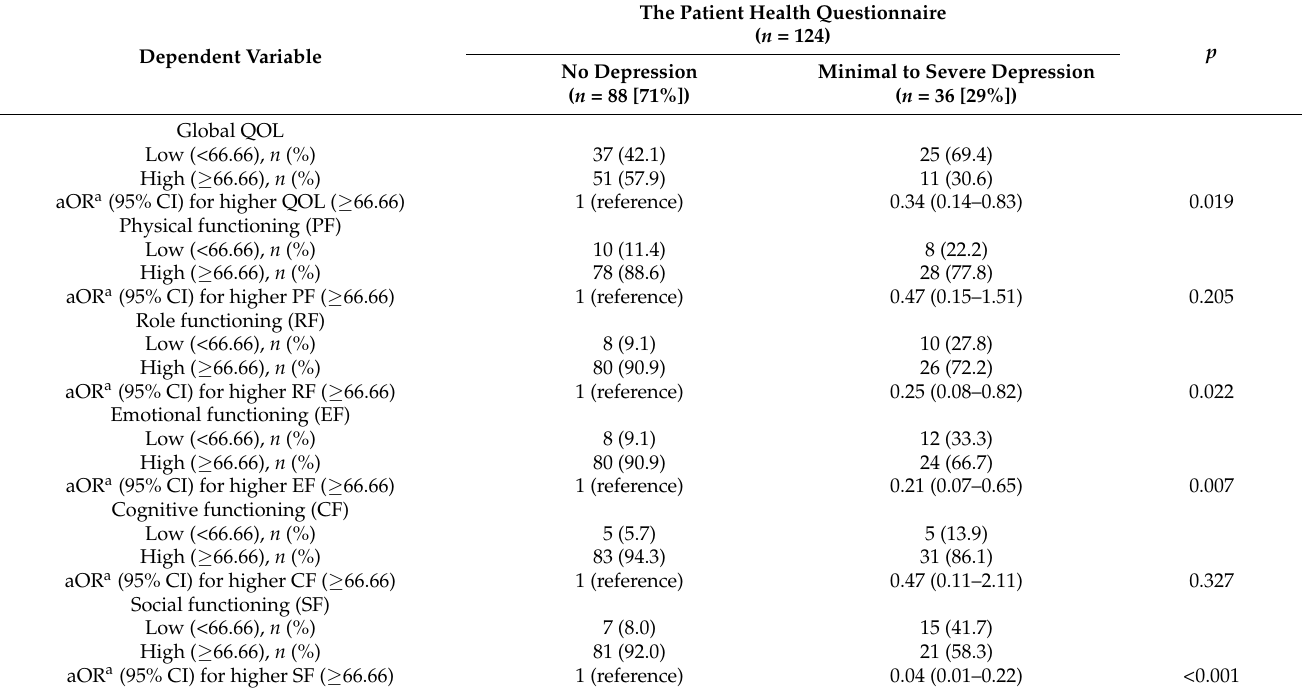
Table 3. Multivariate analyses: association between depression status and health-related quality of life.